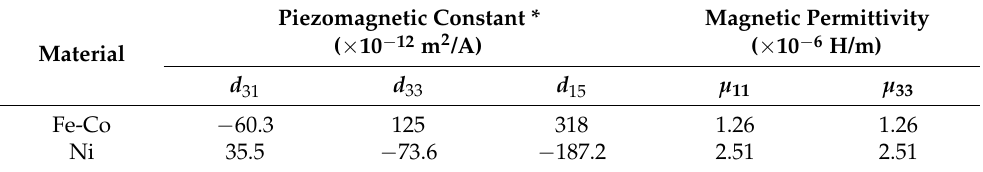
Table 3. Piezomagnetic constant and magnetic permittivity of the Fe-Co and Ni layer.